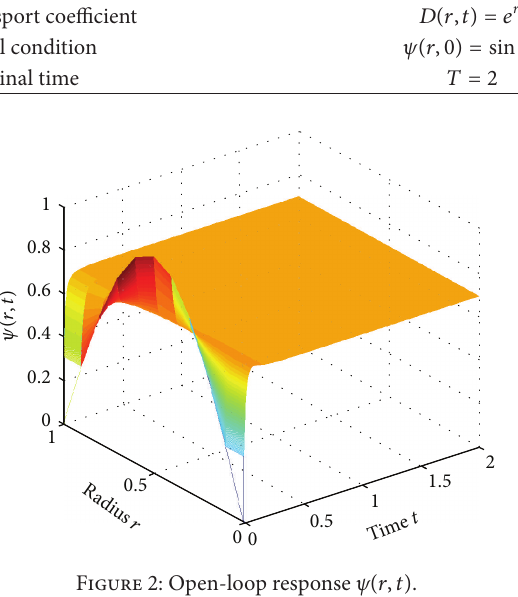
Figure 2: Open-loop response 𝜓(𝑟, 𝑡) .